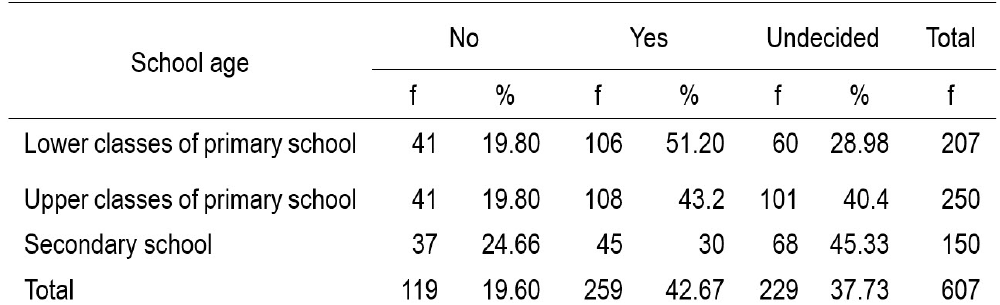
Teachers’ views on online teaching as a predictor of student